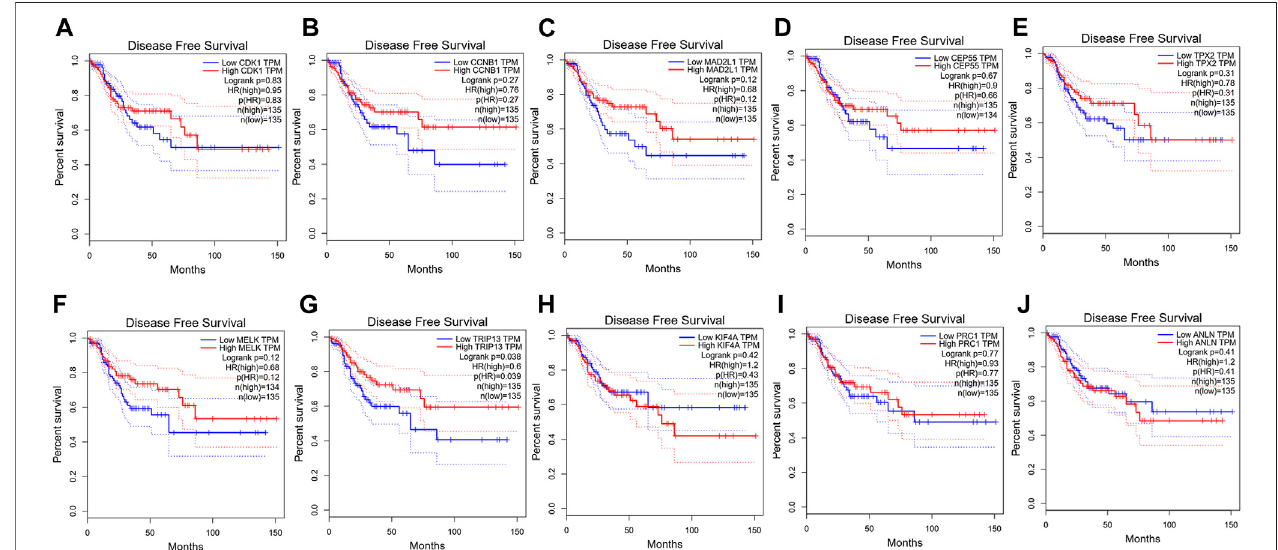
FIGURE 5 | Disease-free survival analysis of CRC in relation to the expression of the 10 hub genes. (A) CDK1, (B) CCNB1, (C) MAD2L1, (D) CEP55, (E) TPX2, (F) MELK, (G) TRIP13, (H) KIF4A, (I) PRC1 and (J) ANLN.